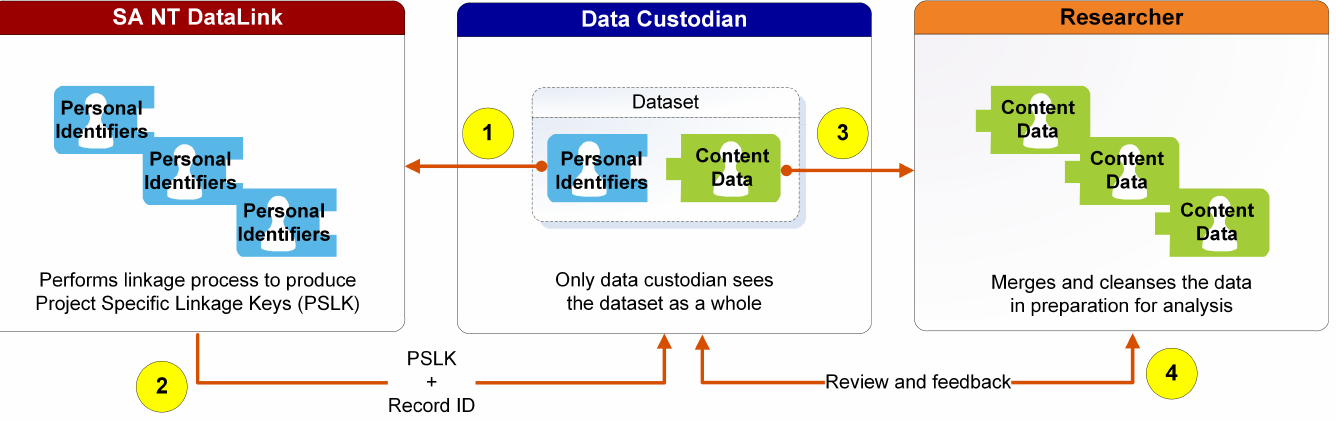
Figure 2: High-level diagram of the data linkage workflow and separation principle as it applies at SA NT DataLink (Source: SA NT